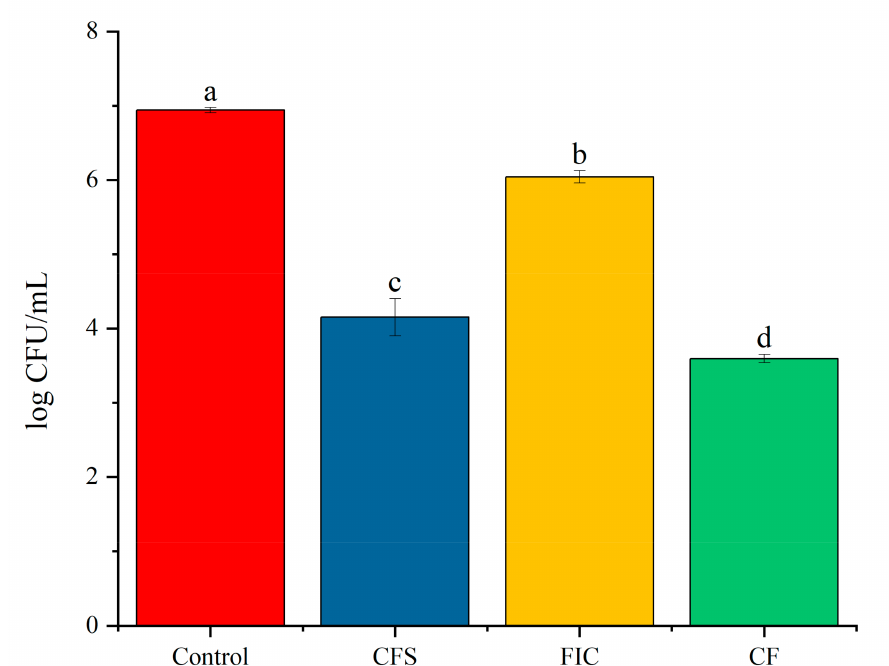
Figure 7. Survival rate of the H. pylori 3192 biofilm under different treatments. CFS: 1/2 × MIC of LN12 CFS treatment, FIC: 1 × FIC of AMX and CLR treatment, CF: 1/2 × MIC of LN12 CFS in combination with 1 × FIC of AMX and CLR treatment. The experimental data are represented by the mean ± standard deviation ( n = 3), and the groups marked with different superscript letters indicate statistically significant differences ( p < 0.05). AMX: Amoxicillin, CLR: Clarithromycin.